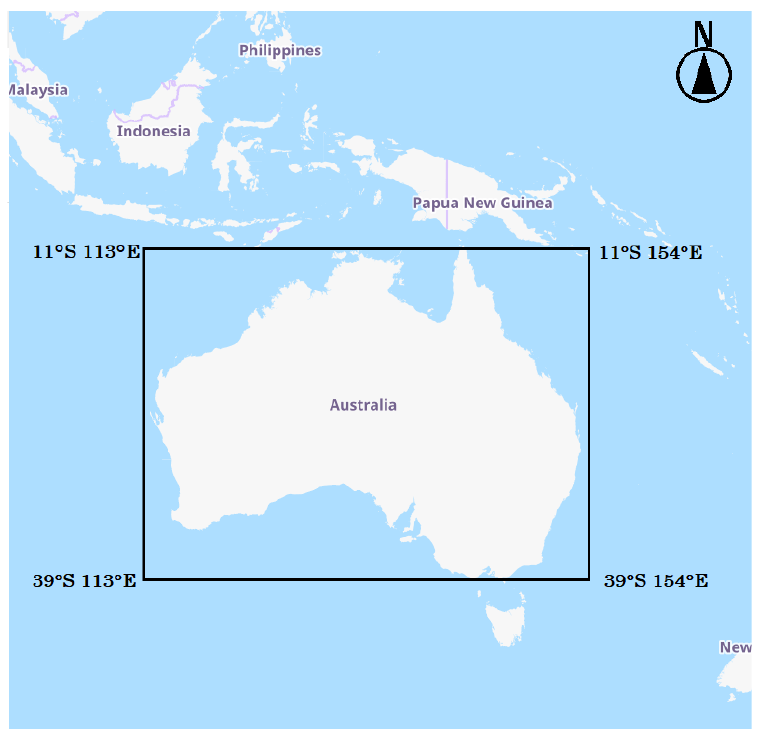
Figure 2. Location of study area (provided by